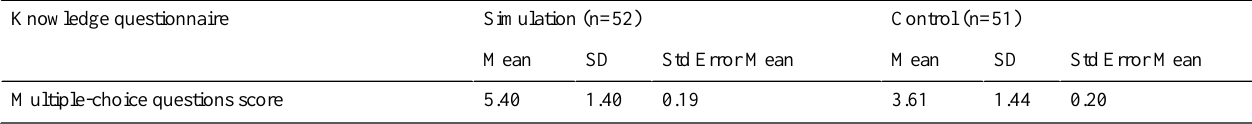
Table 2. Knowledge test scores of the two groups.